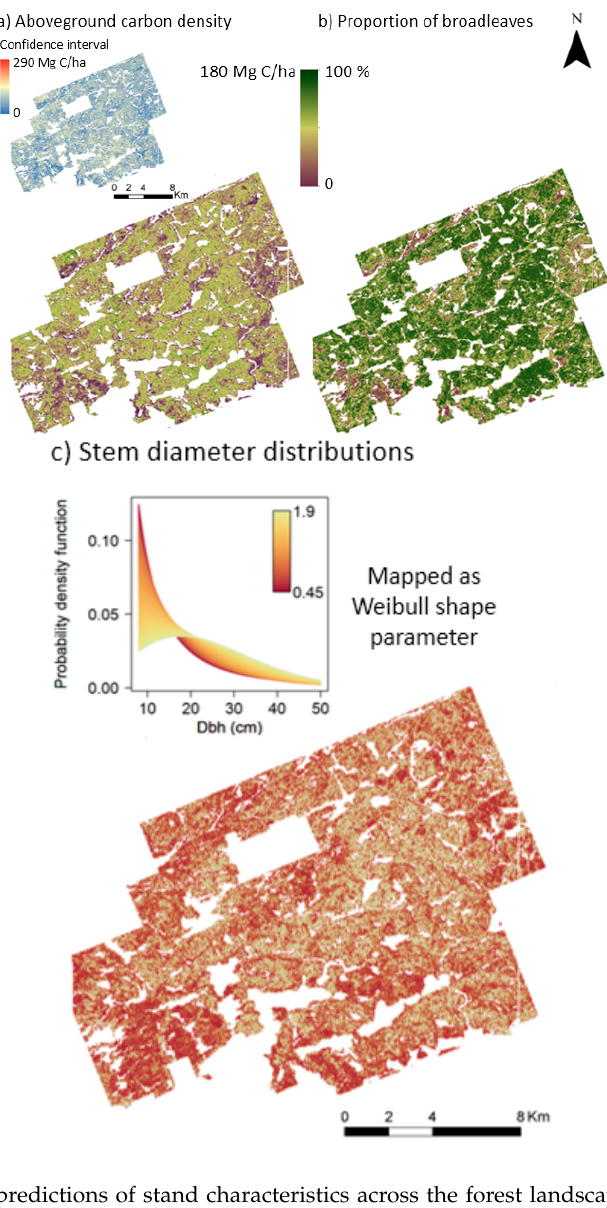
Figure 6. Mapped predictions of stand characteristics across the forest landscape. Purple regions correspond with ( a ) low ACD and ( b ) low broadleaf density, and green regions correspond with ( a ) high ACD and ( b ) high broadleaf density. In ( c ) red regions correspond with a “reverse J” distribution and yellow regions with a unimodal distribution when predicted SDDs are reduced to the single best-fit axis of variation depicted in the inset figure (also see Figure S2). White regions represent non-forested areas, such as lakes, or land not under the same ownership as the forest.